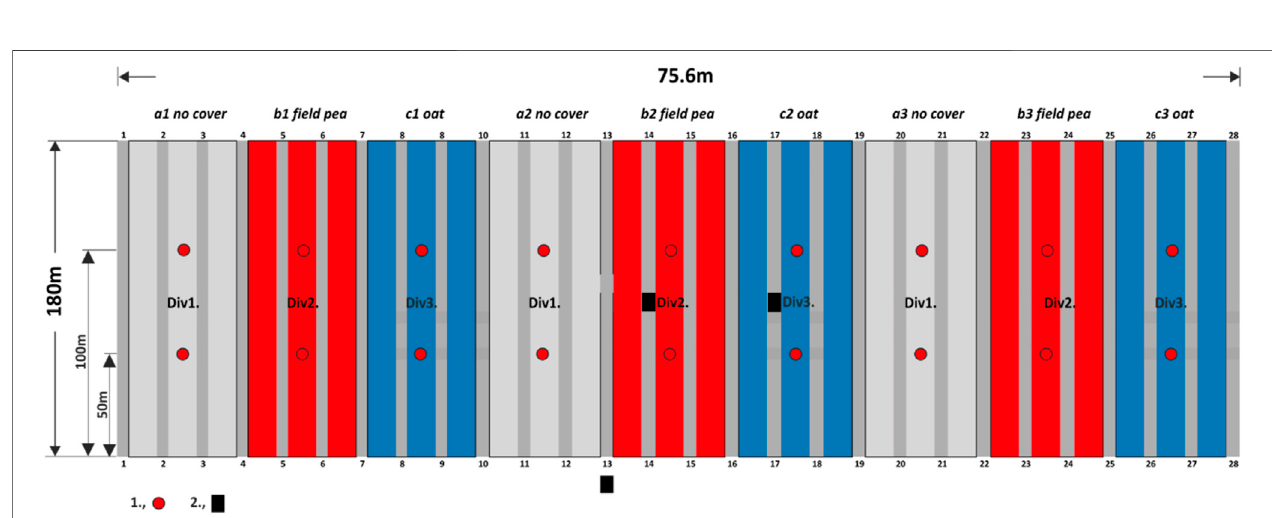
FIGURE 2 | Experimental plot design of CS10 1: ,chambers, 2, in situ loggers for environmental parameters.